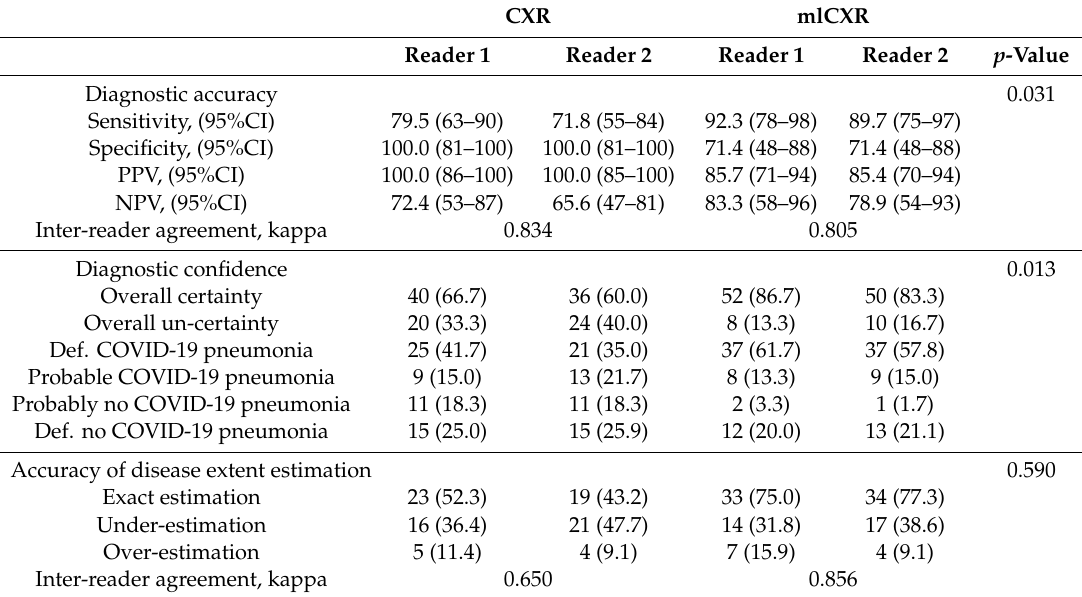
Table 3. Diagnostic